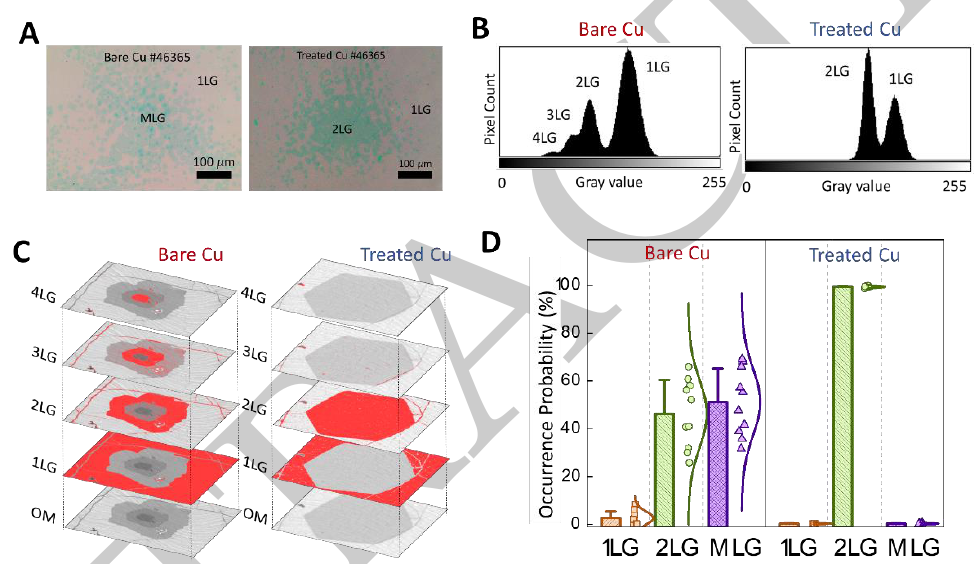
Figure 2. Optical microscopy analysis of graphene samples: ( A ) Typical optical images of graphene samples grown on bare (left panel) and treated (right panel) Cu, then transferred onto SiO 2 /Si substrates; ( B ) Pixel counts as a function of gray values for two microscopy images of typical graphene samples grown on bare (left panel) and treated Cu (right panel) substrates; ( C ) Statistical labeling for each layer of graphene; ( D ) Occurrence probability for different graphene layers, statistically identified using the method shown in ( B ) and ( C ), from 20 typical optical images taken from both types of graphene samples (10 each). Multilayer graphene (MLG) represents 3LG, 4LG, and above.